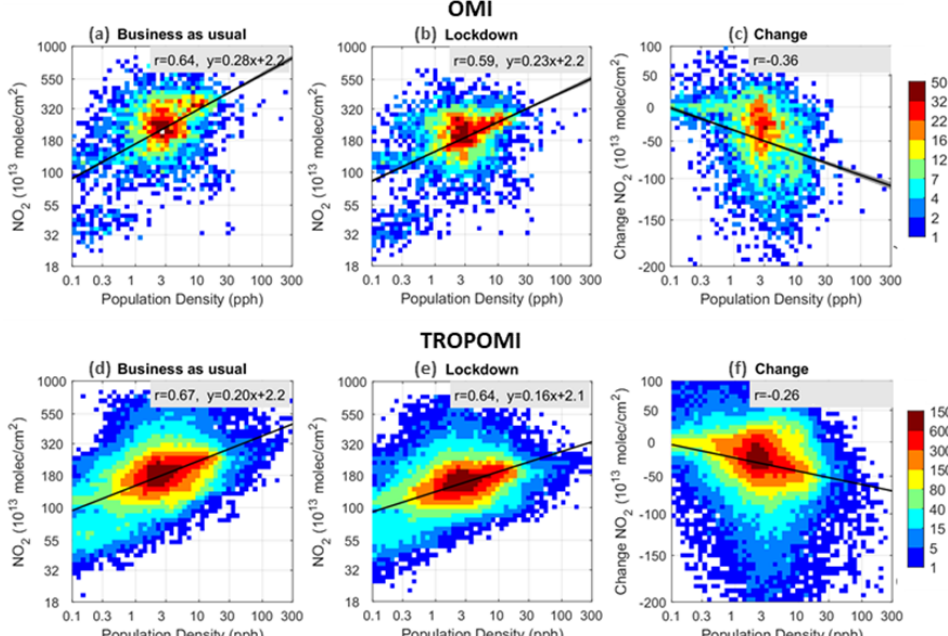
Figure 9. Scatter density plot between the VCD trop NO 2 ( × 10 13 molec.cm − 2 ) and population density (pph) for the analysis period in different years. (a) Business as usual (BAU, 2016–2019) observed by OMI; (b) lockdown (LDN, 2020) observed by OMI; (c) changes (LDN − BAU) observed by OMI; (d) BAU (2019) observed by TROPOMI; (e) LDN (2020) observed by TROPOMI; (f) LND-BAU changes observed by TROPOMI. The linear best fit lines show the log–log relationship between VCD trop NO 2 ( Y ) and population density ( X ) given by equation y = β · x + c , where y = log (Y) , x = log (X) and c = log (C) . Therefore, the equation can be written as log (Y) = β · log (X) + log (C) or Y = C · X β , where β is the slope of the line.